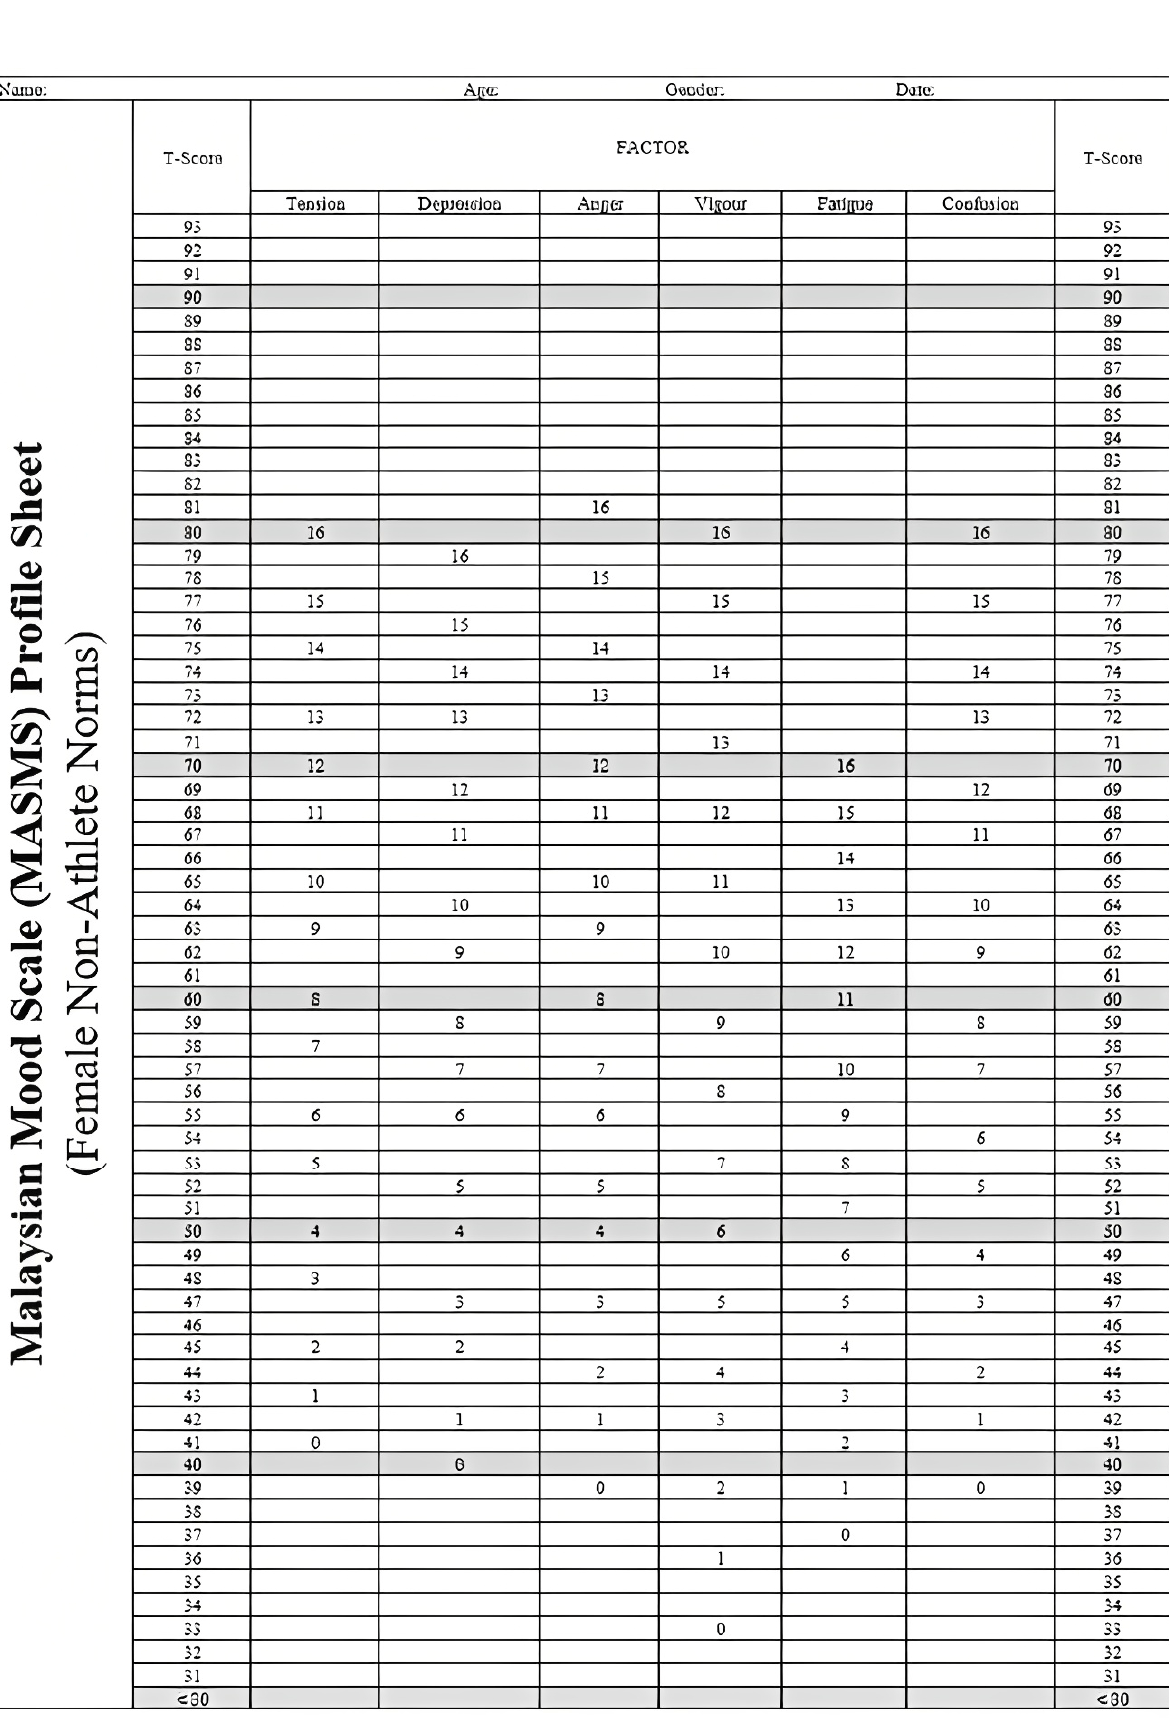
Figure A5. MASMS profile sheet (female non-athlete norms).